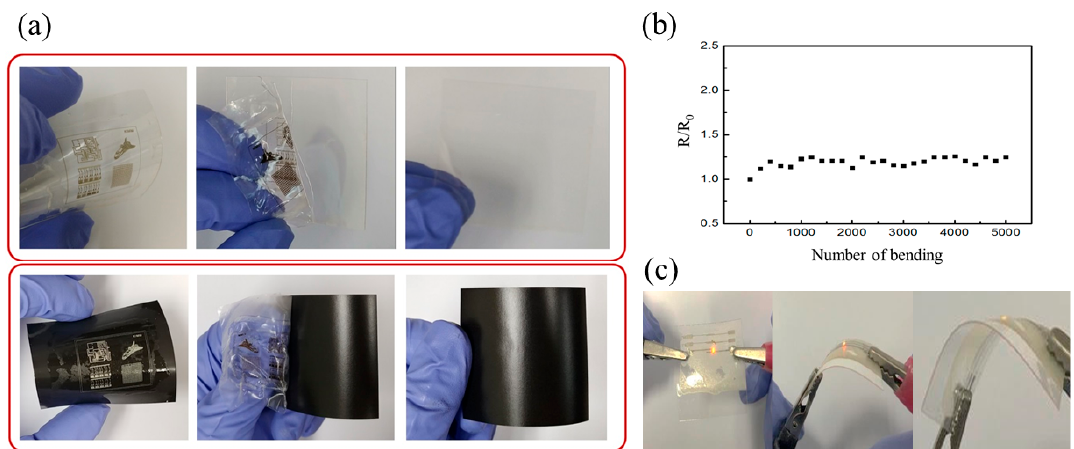
Figure 5. Various patterns fabricated on PET and burning paper and removal of the composite SBS ( a ); Measured resistance variation (R/R 0 ) after the cyclic bending test ( b ); Bending test of the fabricated electric device after laser reduction of the Ag precursor ( c ).